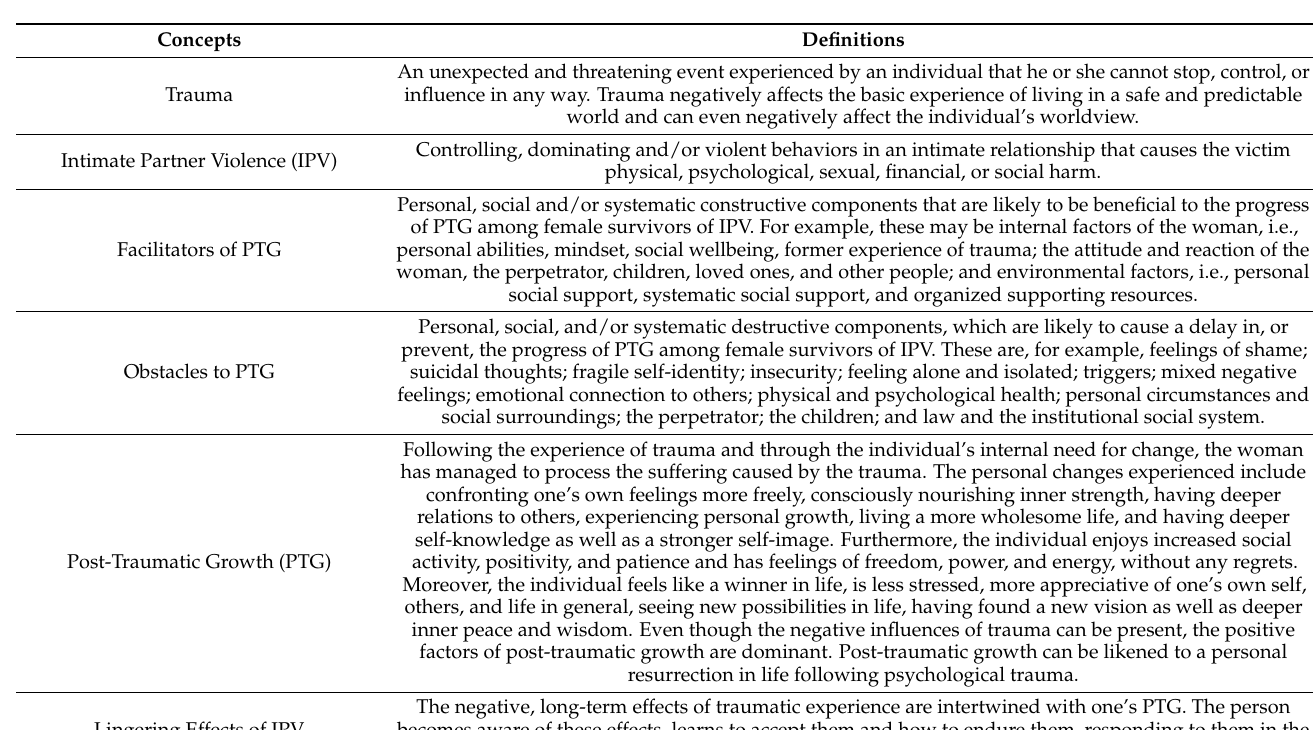
Table 4. The main concepts of the theory—defined by the authors for the